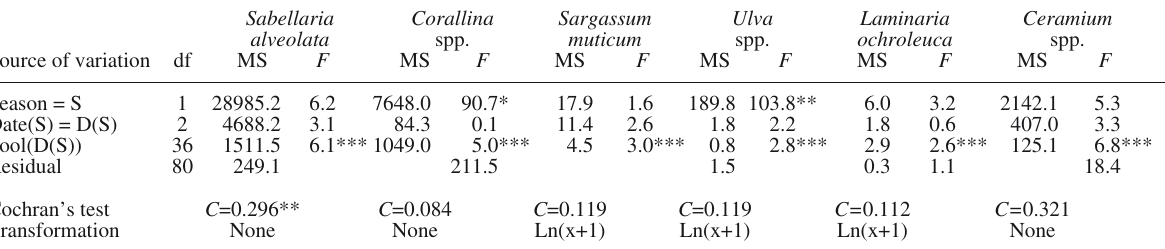
Fig . 2. – Mean (+SE) percentage cover of individual taxa (A, B and F: untransformed data; C, D, E, G, H, I and J: log-transformed data) in winter (black) and summer (white). Data averaged over three replicate quadrates, ten pools and two dates. Table 3. – Summary of ANOVAs for individual taxa from rock pool assemblages. * p<0.05; ** p<0.01, *** p < 0.001.